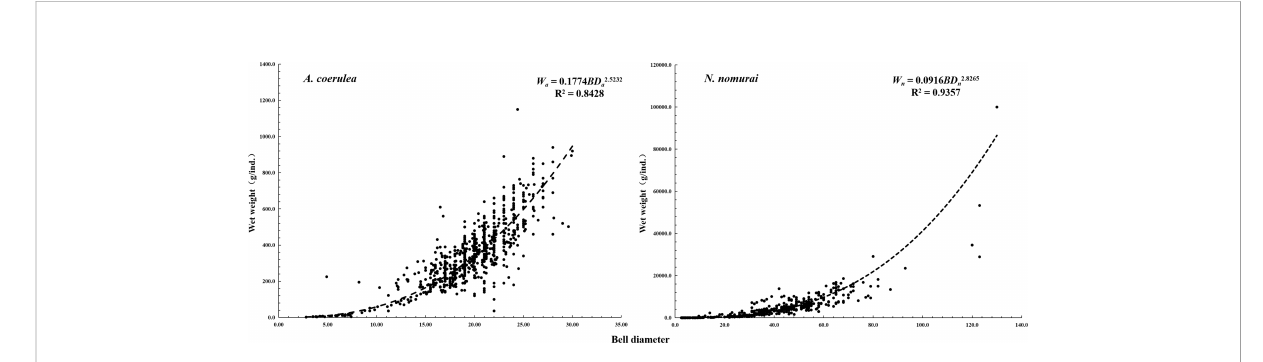
FIGURE 6 Relationship between the BDs and WWs of N. nomurai and A. coerulea .